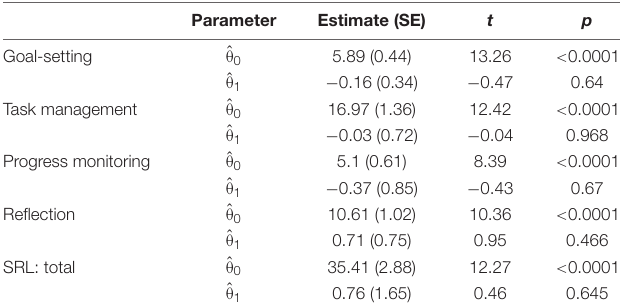
TABLE 3 | Results of the two-level analyses of self-regulated learning (SRL) journals data by domains.